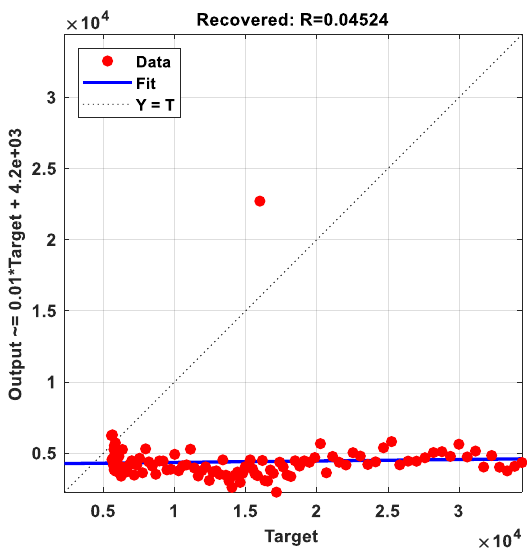
( a ) The correlations coefficients and the linear regression equations between the observed infected values and the target values (PPA-MMLPNN model values) for Mexico.